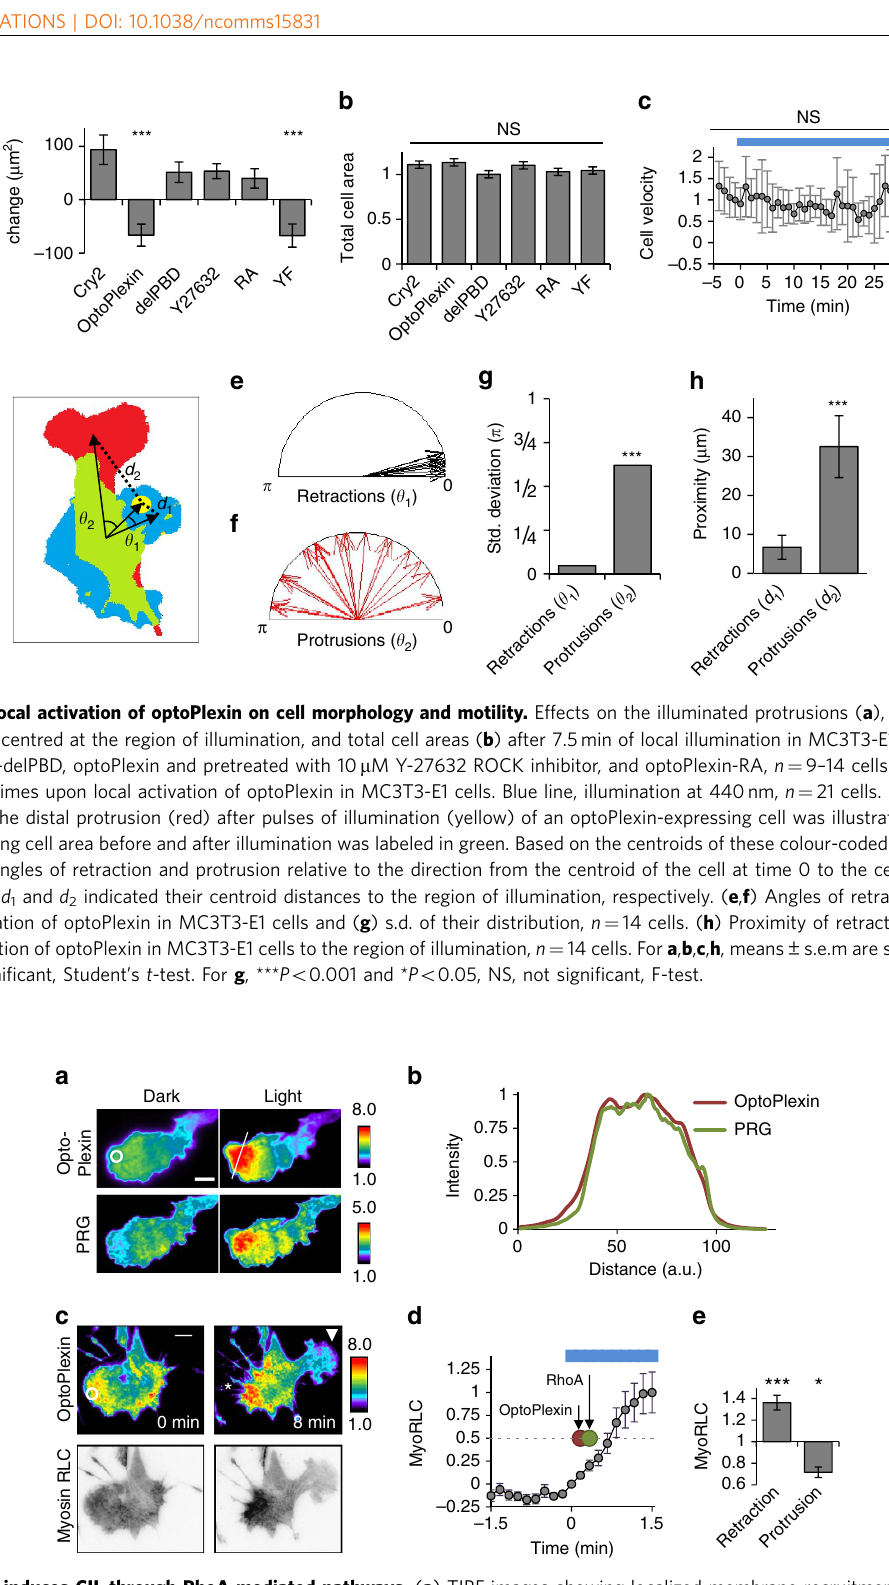
Figure 6 | OptoPlexin induces CIL through RhoA-mediated pathways. ( a ) TIRF images showing localized membrane recruitment of mVenus-PRG with mCherry-optoPlexin in MC3T3-E1 cells upon local illumination. White circle, region of illumination. Scale bar, 10 m m. ( b ) Normalized intensities of mCherry-optoPlexin and mVenus-PRG after local illumination in a linescan analysis. Reference line for the linescan is shown in the right top panel of a . ( c ) TIRF images showing a polarized distribution of mCherry-MyoRLC upon local activation of mVenus-optoPlexin in MC3T3-E1 cells. White circle, region of illumination. Asterisk, induced retraction. Arrowhead, induced protrusion. Scale bar, 10 m m. ( d ) Temporal changes in average mCherry-MyoRLC intensity in a 50 m m diameter circle around the region of illumination (white circle) in MC3T3-E1 cells upon localized activation of mVenus-optoPlexin. Red and green circles indicate t 1/2 for optoPlexin and RhoA inductions, respectively, as estimated from Supplementary Fig. S4b. Blue line, illumination at 440nm. ( e ) Relative intensities of mCherry-MyoRLC in retractions and new protrusions induced by local activation of mVenus-optoPlexin, normalized to the whole cell average. For d , e n ¼ 12 cells, means ± s.e.m. *** P o 0.001 and * P o 0.05, NS, not significant, Student’s t